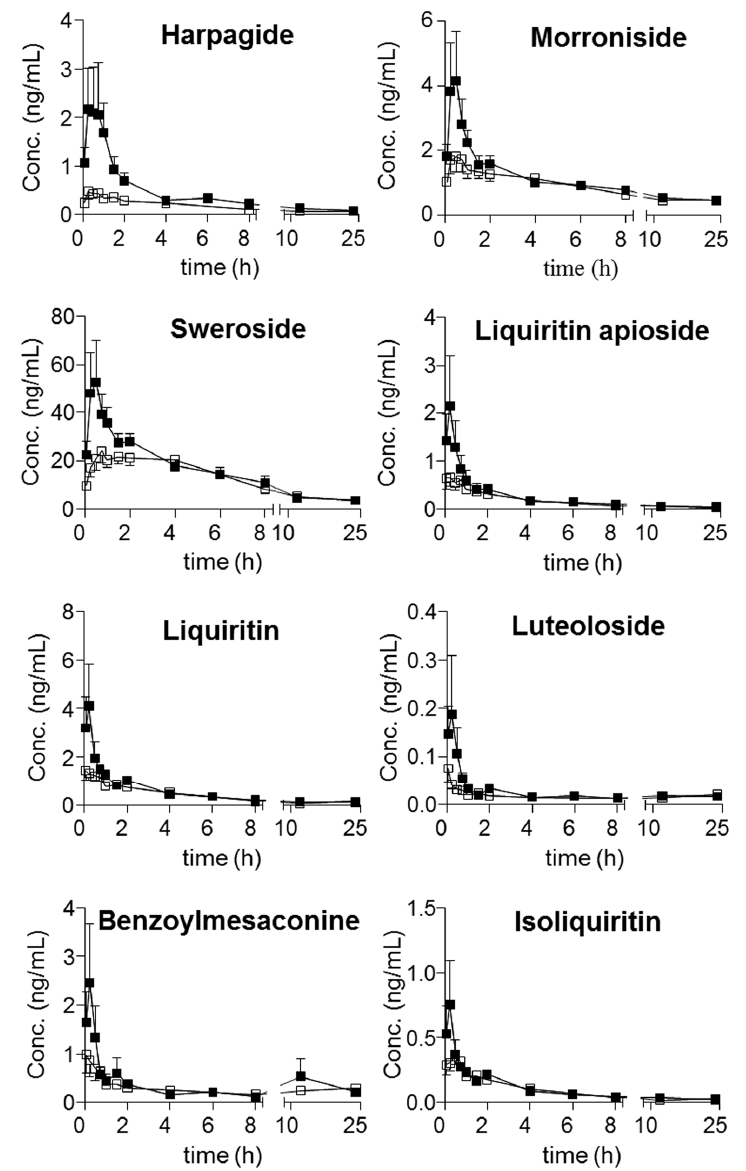
Figure 3 . Cont. Figure 3.